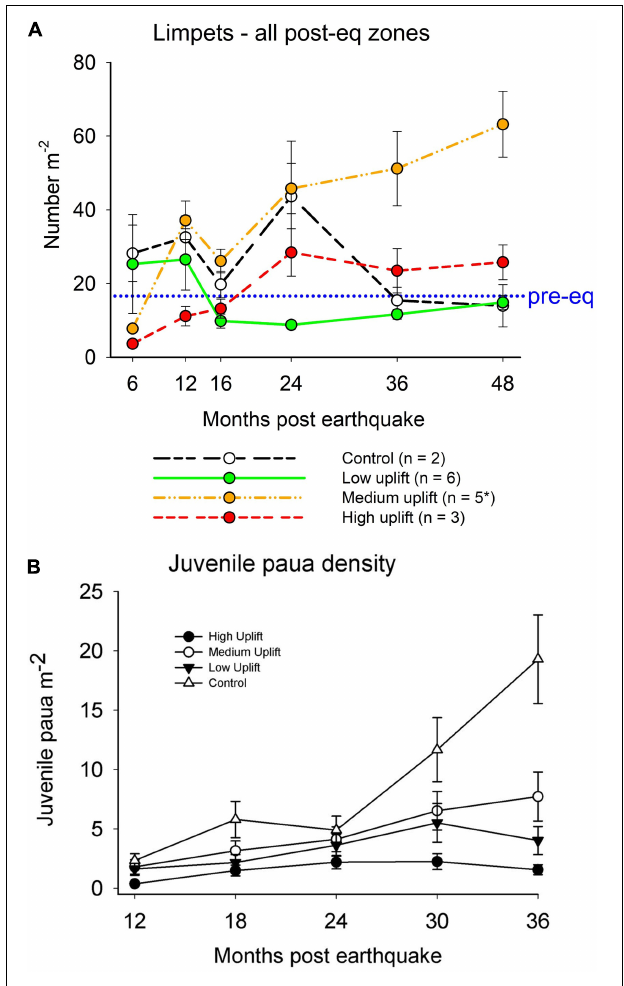
FIGURE 8 | | (A) Time series of the mean number ( ± SE) of limpets per m 2 across uplift levels. The dotted blue line indicates the average abundance of limpets across sites sampled in November 2016. (B) The abundance of juvenile ( < 80 mm shell length) and adult ( > 80 mm) pâua ( Haliotis iris ) in the low intertidal zone of study sites in different degrees of uplift over 3 years